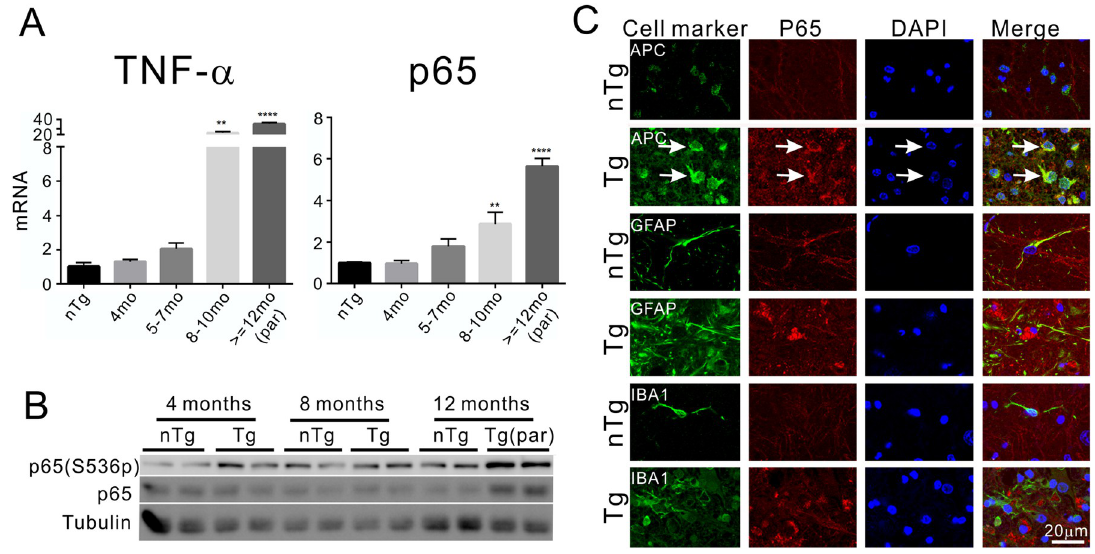
Fig 9. Activation of NF-kB pathway in the Tg mice. (A) TNF- α and p65 mRNA levels were dramatically elevated in the symptomatic Tg mice, and the peak was correlated with paralysis. The value of nTg mice is an average from eight animals with the age range from 102 days to 436 days. The nTg mice did not show an age-dependent change and therefore grouped together. Student t tests with Bonferroni correction were used to compare between the Tg and the nTg mice at different ages. n = 4–8 at each age for both groups. �� = p < 0.01, ���� = p < 0.0001. (B) Western blot analysis showed both the phosphorylated p65(S536p) and the overall p65 levels were increased near symptomatic onset and paralysis stage in the Tg mice. (C) Immunostaining for p65 and markers of glial cells show localization of the increased p65 in the oligodendrocytes (arrows) but not in astrocytes and microglia in the Tg mice.